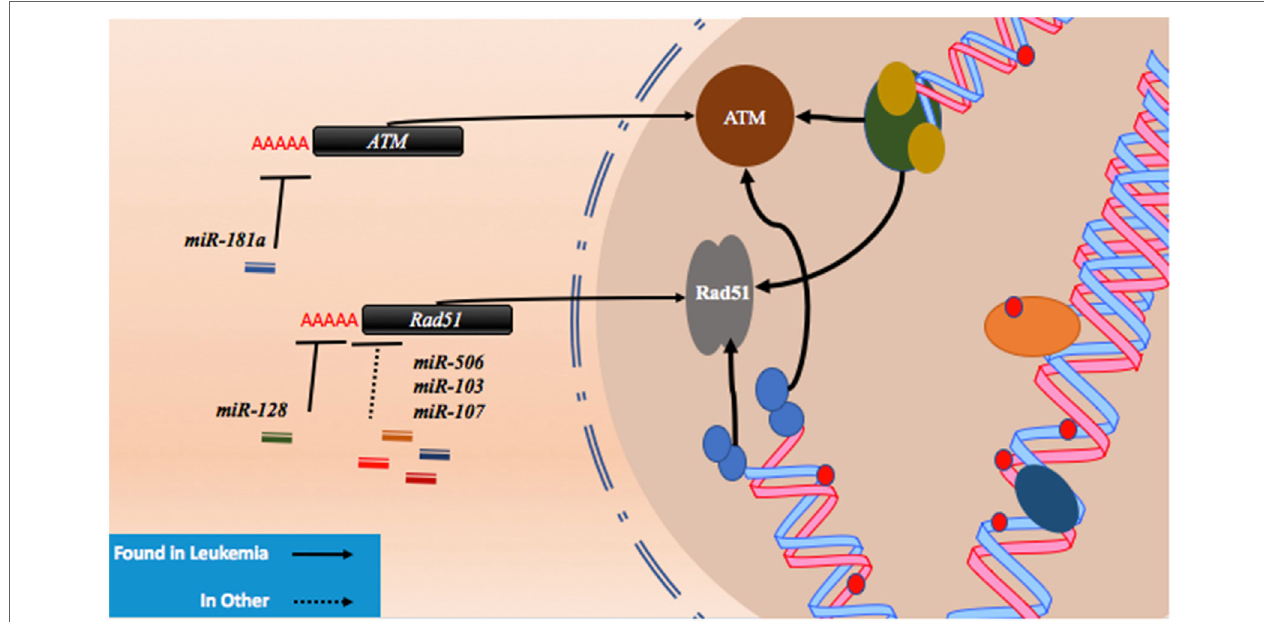
FigURe 2 | microRNAs (miRNAs) regulate DNA damage response by regulating proteins that behave as DNA damage response elements. In the process of generating DNA damage through genotoxic drugs such as the anthracyclines and the cytosine analogs, the upregulation of effector and response proteins such as ataxia telangiectasia mutated (ATM) and Rad51 is likely to occur. The inhibition of ATM through miR-181a targeting allows tolerance for DNA damage. Reduction of Rad51 through miR-128, miR-506, miR-103, and miR-107 reduces DNA damage response and also contributes to DNA damage